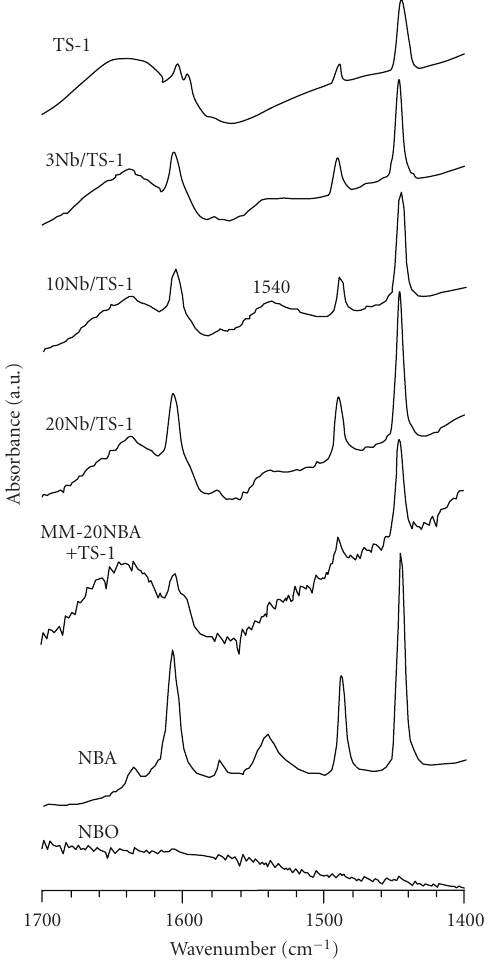
Figure 7: FTIR spectra of the NBA, NBO, TS-1, and X Nb/TS-1 samples after evacuation at 200 ◦ C for 24 hours followed by pyridine adsorption at room temperature and evacuation at 150 ◦ C for one hour, in the pyridine regions.